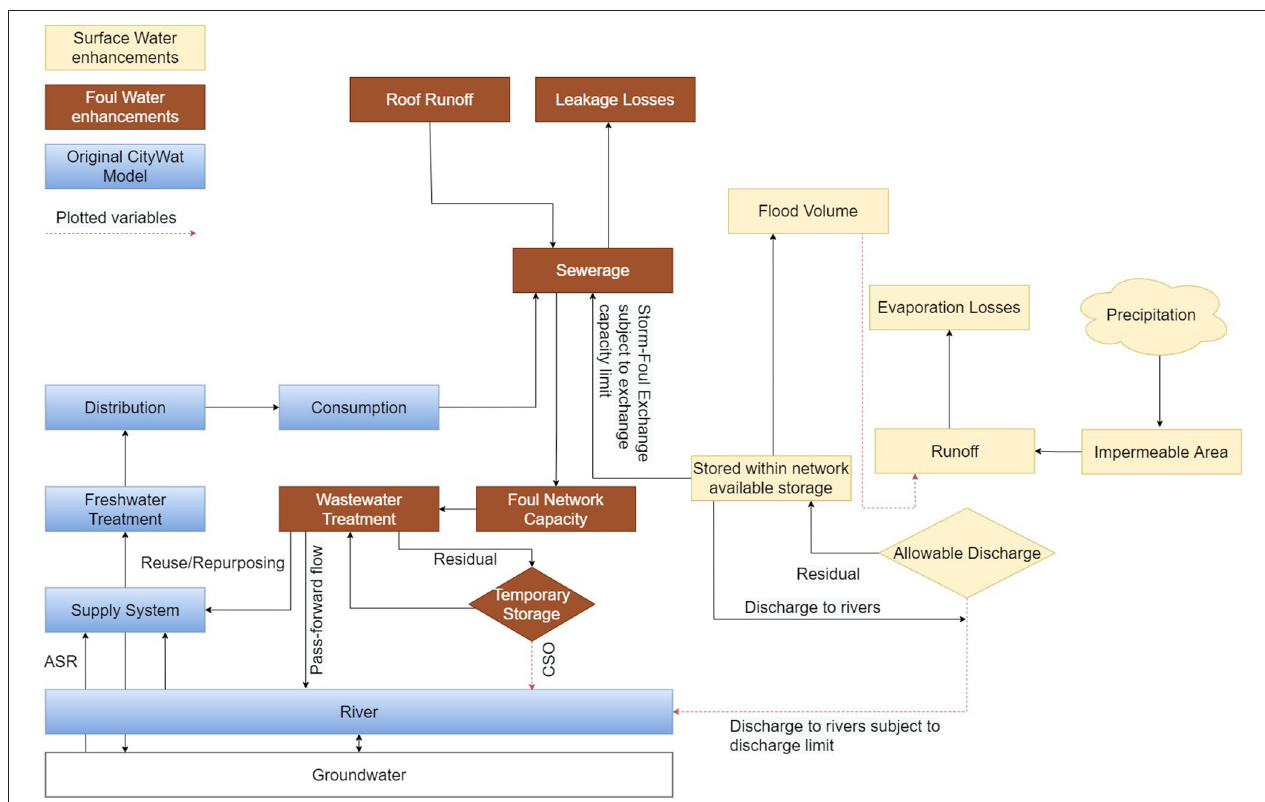
FIGURE 2 | Integrated water supply and wastewater modelling using CityWatStorm. Blue components show the original CityWat model. Brown components show the novel CityWatStorm foul water processes, and the beige components show the surface water processes developed as part of this